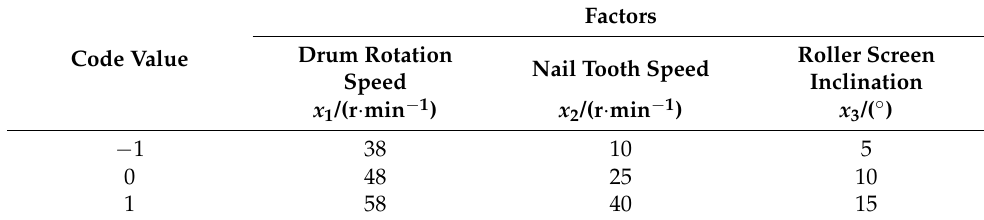
Table 1. Test factor code.